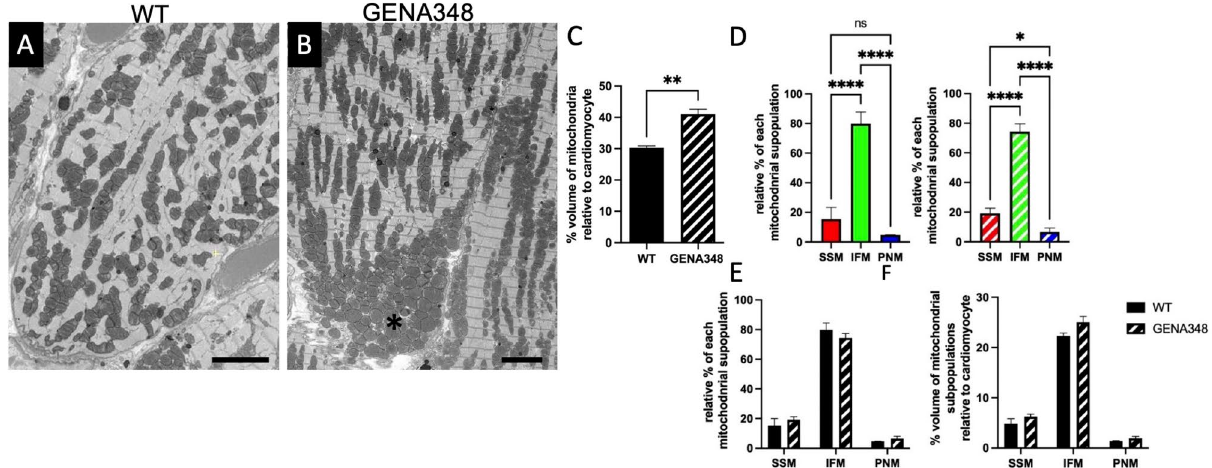
Figure 4. GENA348 myocardium has an increased mitochondrial density compared to the WT. ( A , B ) Portions of serial images from the WT SBF-SEM datasets ( A ) and GENA348 samples highlighting areas (*) of mitochondrial clustering. Scale bar = 5 μm. ( C ) Analysis of mitochondrial density using a stereological approach sampling SBF-SEM data sets (volume sampled per dataset = 58.4 × 58. 4 × 47.0 μm, n = 3 per group). Mitochondrial volume relative to the cardiomyocyte volume density for WT and GENA348 (mean ± SEM; two- tailed unpaired Student t test; ** P < 0.01). ( D ) Analysis of the mitochondrial subpopulation densities relative to the total mitochondrial shows that IFM are the largest mitochondrial subpopulation in both the WT (left) and GENA348 (right) population. In the WT cardiomyocyte the density of SSM and PNM are similar but in the GENA348 myocardium there are more SSM than PNM. ( E ) There is no difference in the density of the WT and GENA348 mitochondrial subpopulations relative to the cardiomyocyte density. ( F ) All mean values of the GENA348 subpopulations are greater than WT, but do not reach significance (2-way ANOVA; Sidaks multiple comparison test) which may be due to the density increase being distributed across all